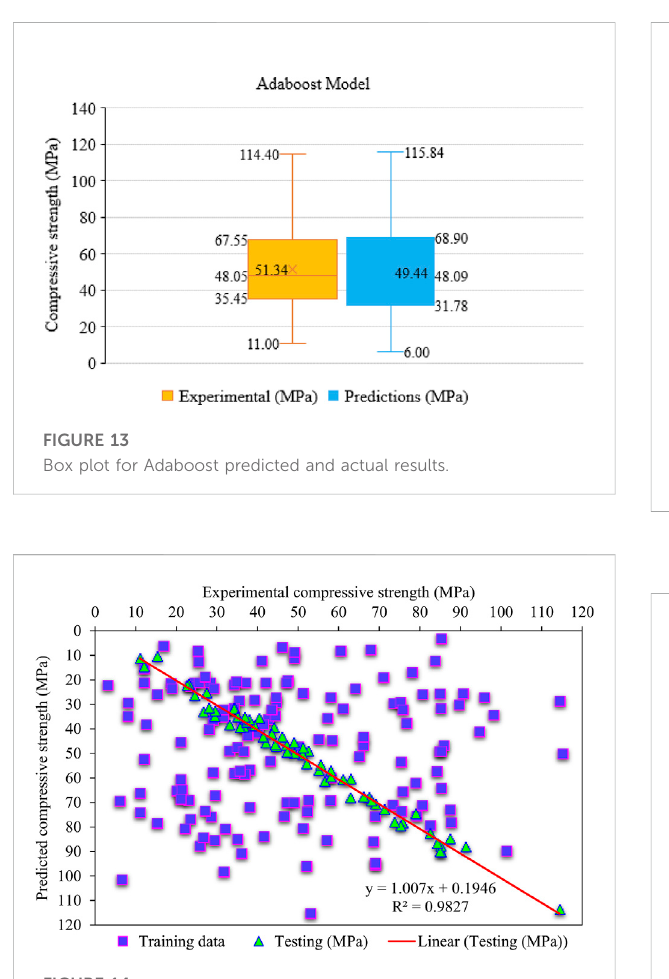
FIGURE 16 Box plot for actual and RF predicted results.